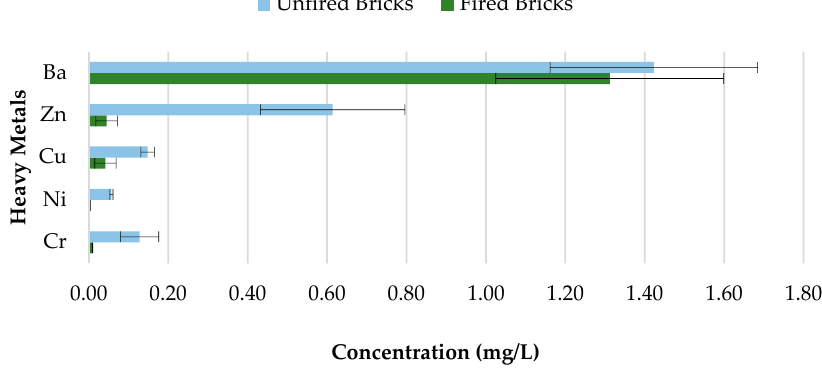
Figure 20. Heavy metal concentration of 1.5% CB content bricks before and after firing.